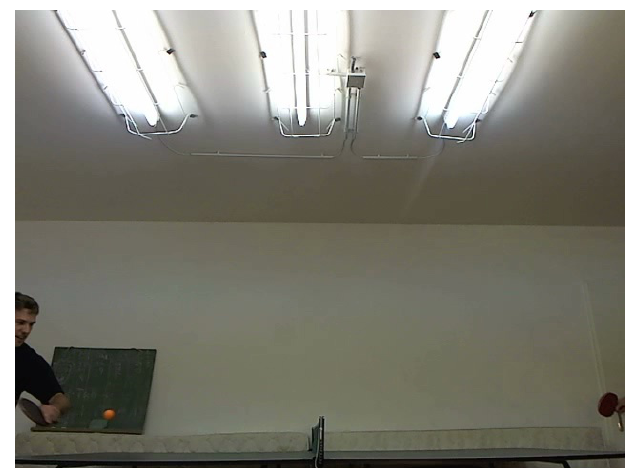
Figure 3. Orange ball tracking. Mostly good contrast with an official game ball of